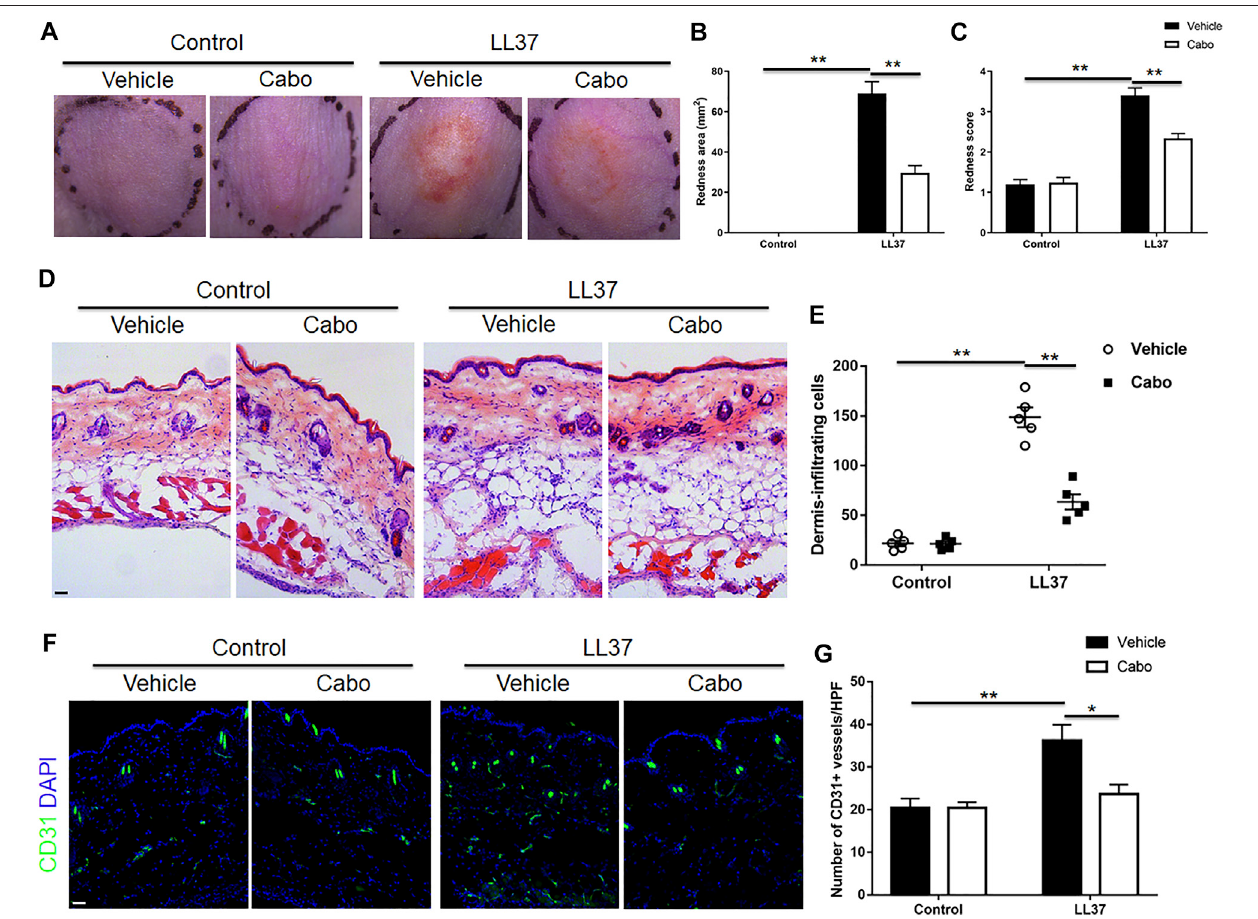
FIGURE 2 | Inhibition of angiogenesis by Cabo alleviates LL37-induced rosacea-like phenotype. (A) Representative photographs of dorsal skin of mice from different groups. (B,C) Quantitative analysis of the redness area (B) and score of erythema (C) in dorsal skin of mice. (D,E) H&E staining and quantitative analysis of the numberofcellin fi ltration.Scalebar:50 μ m. (F,G) Immuno fl uorescencestainingwithCD31andquantitationofCD31 + vesselsinskintissuesfromfourgroups.Scalebar: 50 μ m. Data represent mean ± SEM from three independent experiments. Statistical signi fi cance was determined by One-way ANOVA (B,C,E,G) . * p < 0.05 and ** p < 0.01.